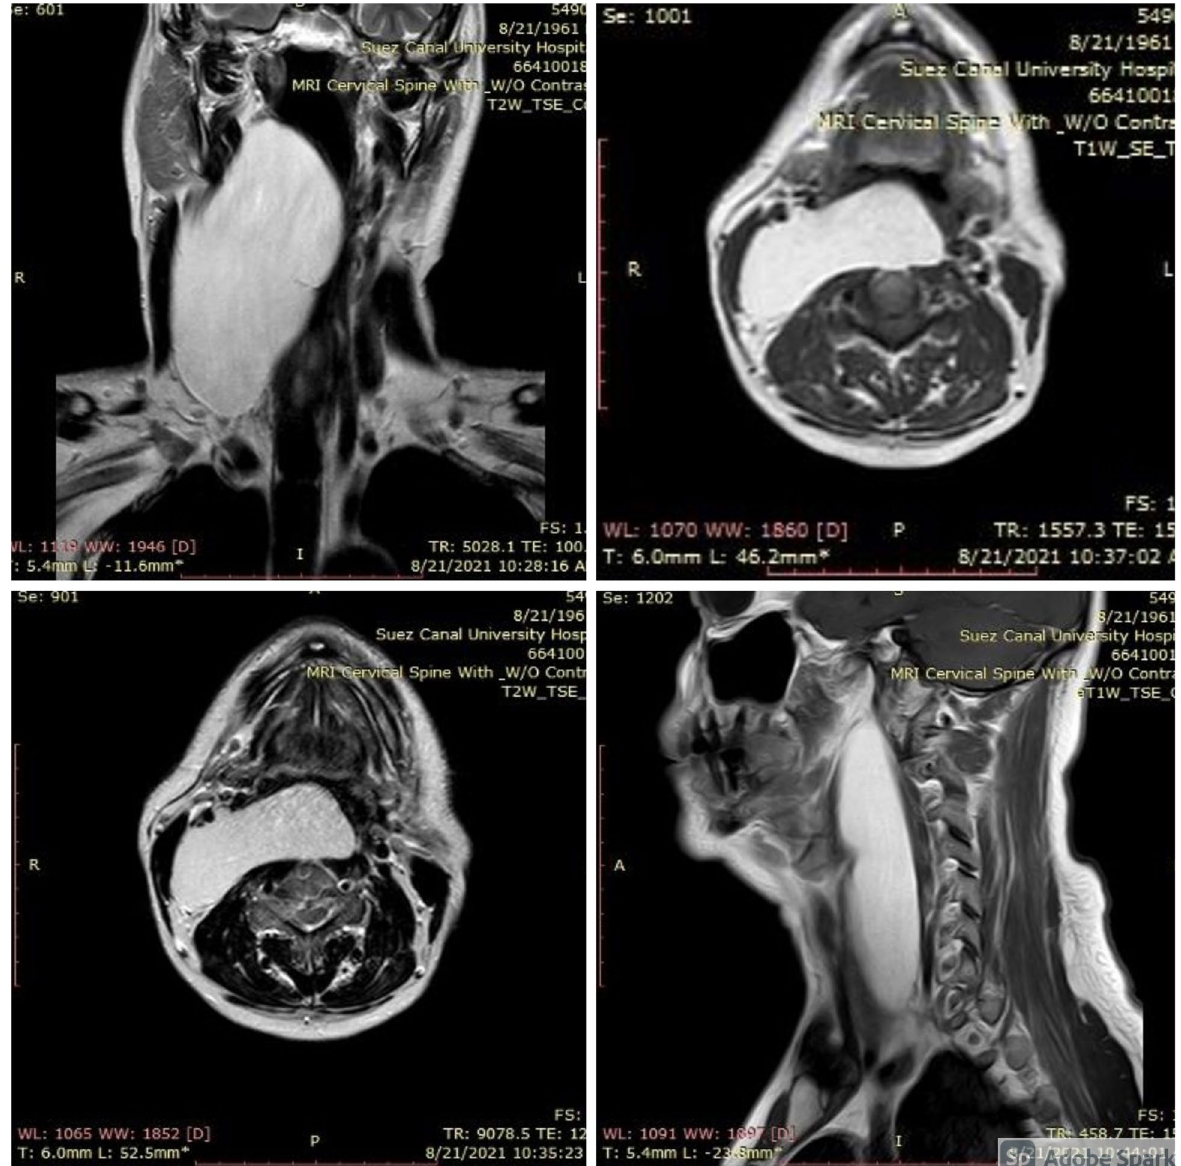
Fig. 2 MRI neck showing antero-medial displacement of the oropharyngeal mucosa with encroachment upon the oropharyngeal airway